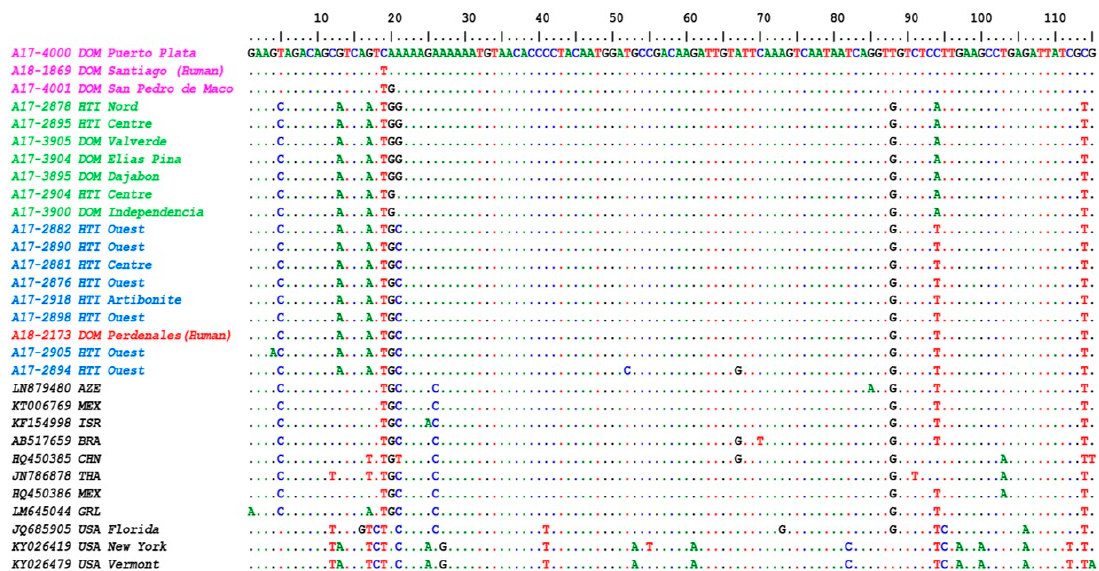
Figure 2. Sequence alignment (115 bp) from LN34 amplicons link the human case A18-2173 (labelled in red) to the RABV strain (blue) circulating mainly in the Ouest Department of Haiti (HTI). Three groups of RABV were identified based on the sequence alignment: HTI contains two groups (blue and green) and DOM has three groups (blue, green, and purple).